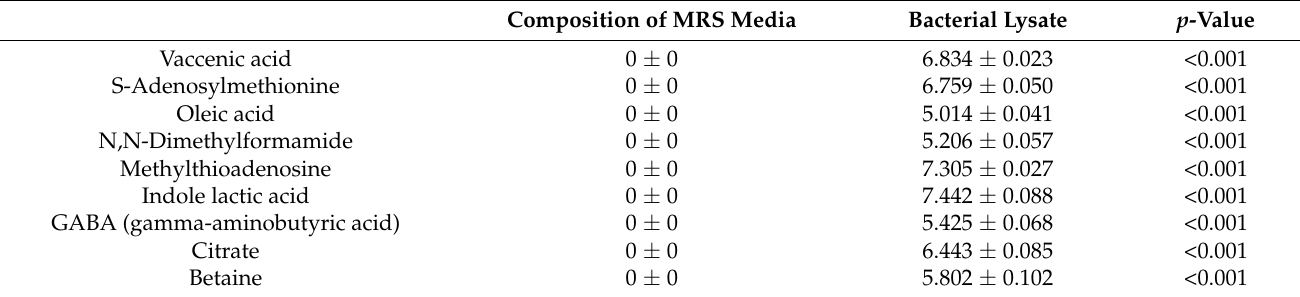
Table 3. Lactococcus lactis GEN3013-derived metabolites. Composition of MRS